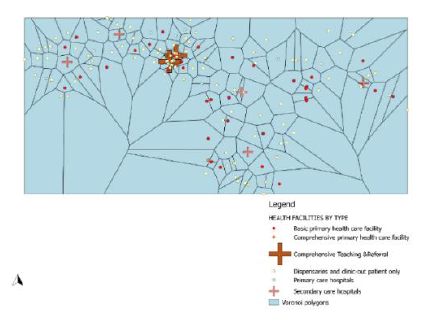
Chart 1: STATA Output: Scatter plot of distance and